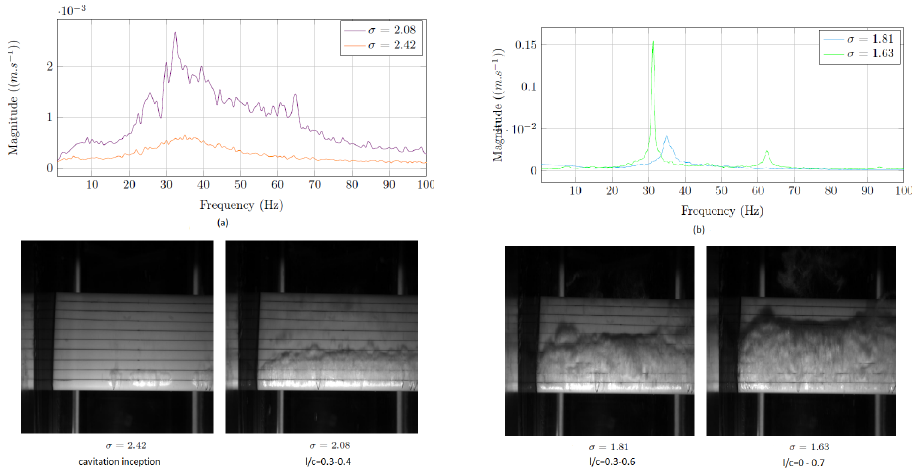
Figure 17. Vibration spectra in cavitating flow and corresponding cavity snapshots on a hydrofoil for various cavitation number: ( a ) high values of σ , ( b ) small values of σ